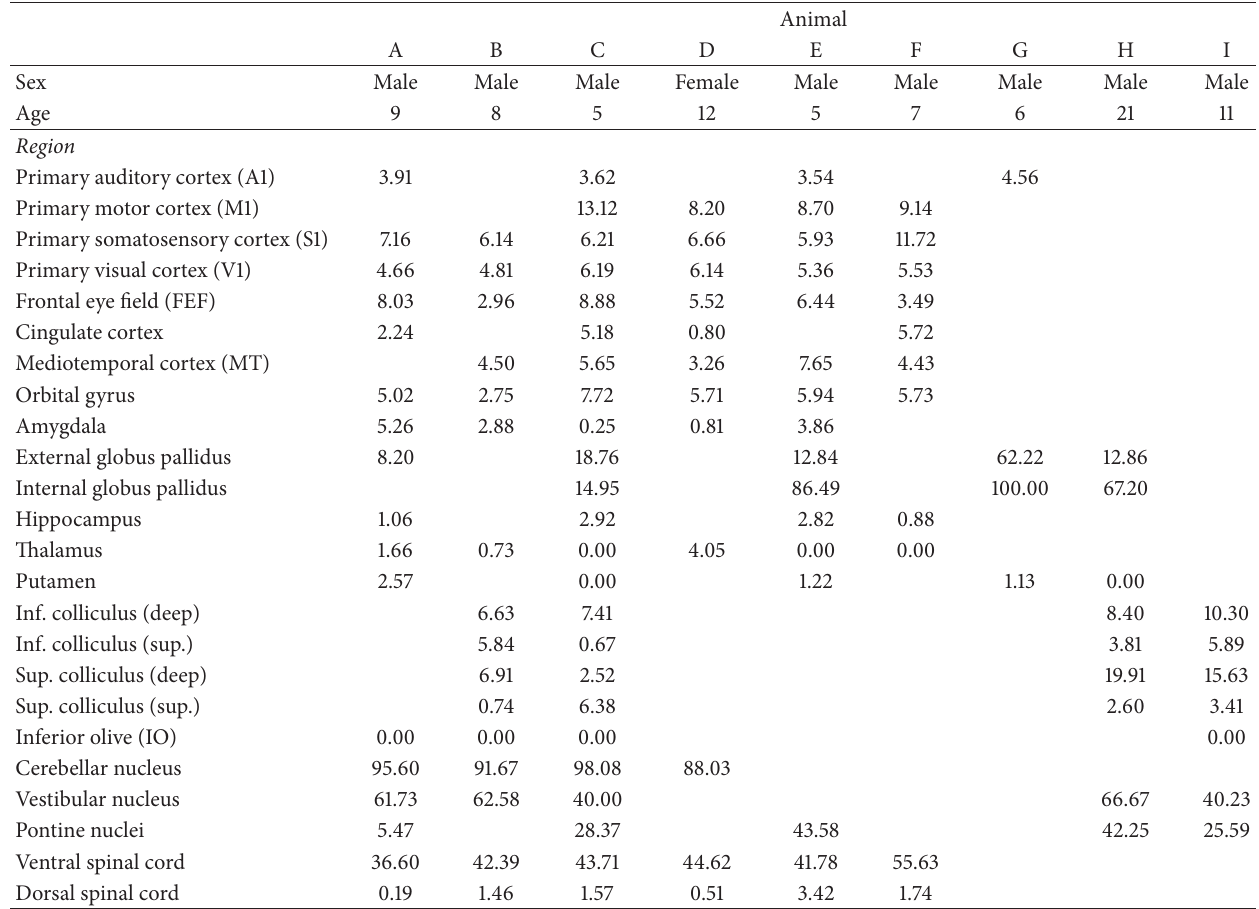
Table 1: Percentages of WFA+ neurons by region and animal. The top rows detail each animal’s sex and age. The subsequent rows show the percentage of neurons that were surrounded by WFA+ PNNs for each region in each animal that we collected data